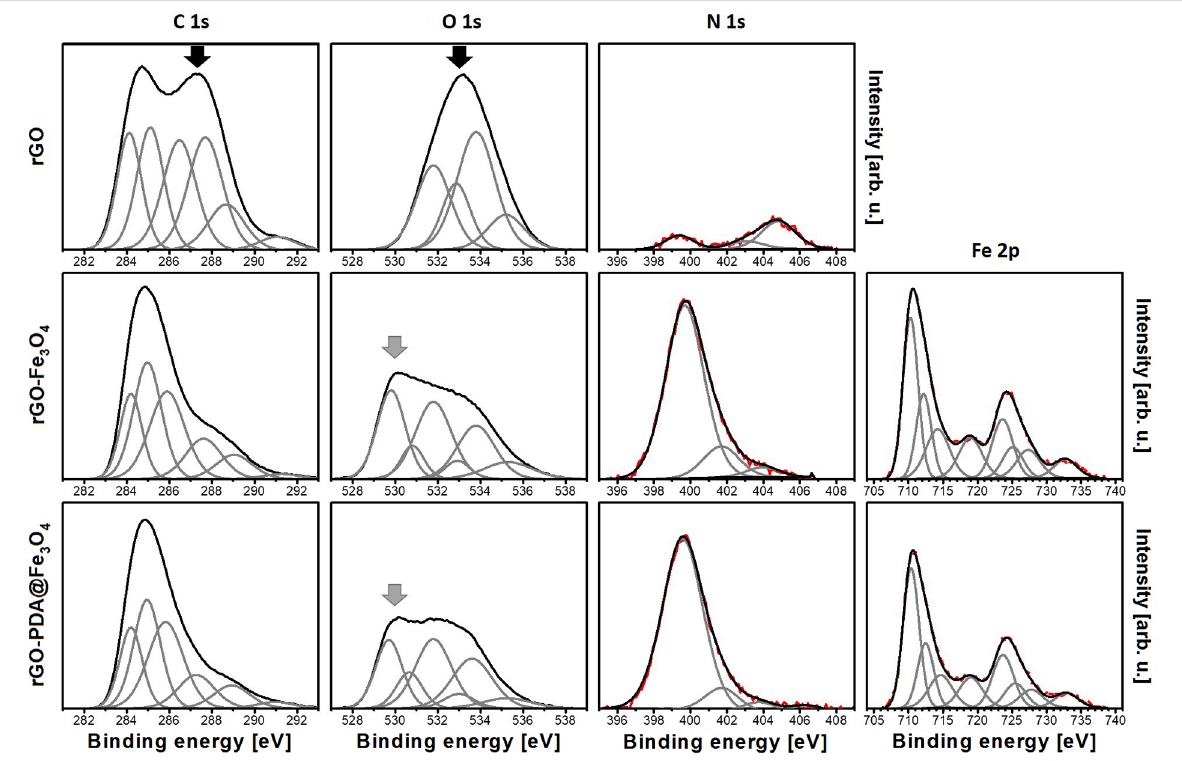
Figure 6: XPS C 1s, O 1s, N 1s and Fe 2p spectra of rGO, rGO-Fe 3 O 4 and rGO-PDA@Fe 3 O 4 aerogel samples. The intensity scales are the same for respective elements (in order to allow for direct comparison).